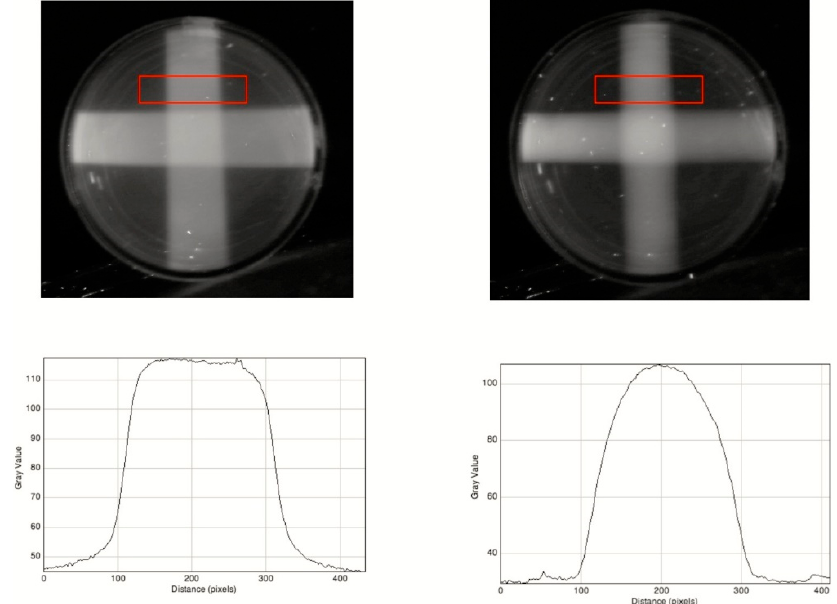
Figure 11. A 20 mm thick RFG gel irradiated with orthogonally-crossed X-ray beams. Upper left : a 10 × 10 mm square beam, Upper right : a 10 mm diameter round beam. Lower : pixel profiles across the beams as shown by the red rectangles. Pixel resolution 0.049 mm/pixel.